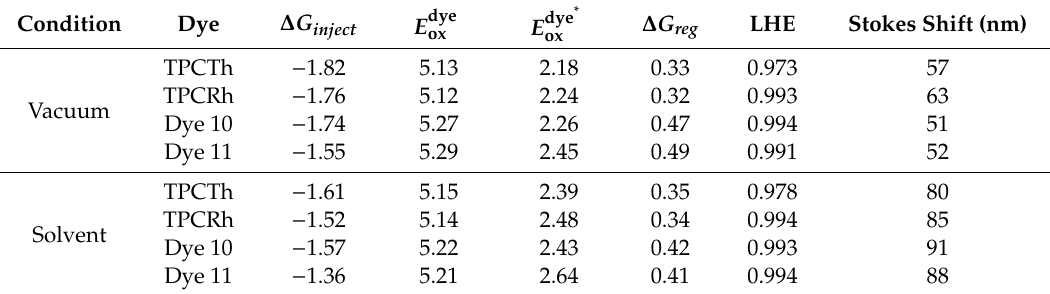
Table 6. Electronic properties of four dyes in vacuum and solvent, respectively (eV).